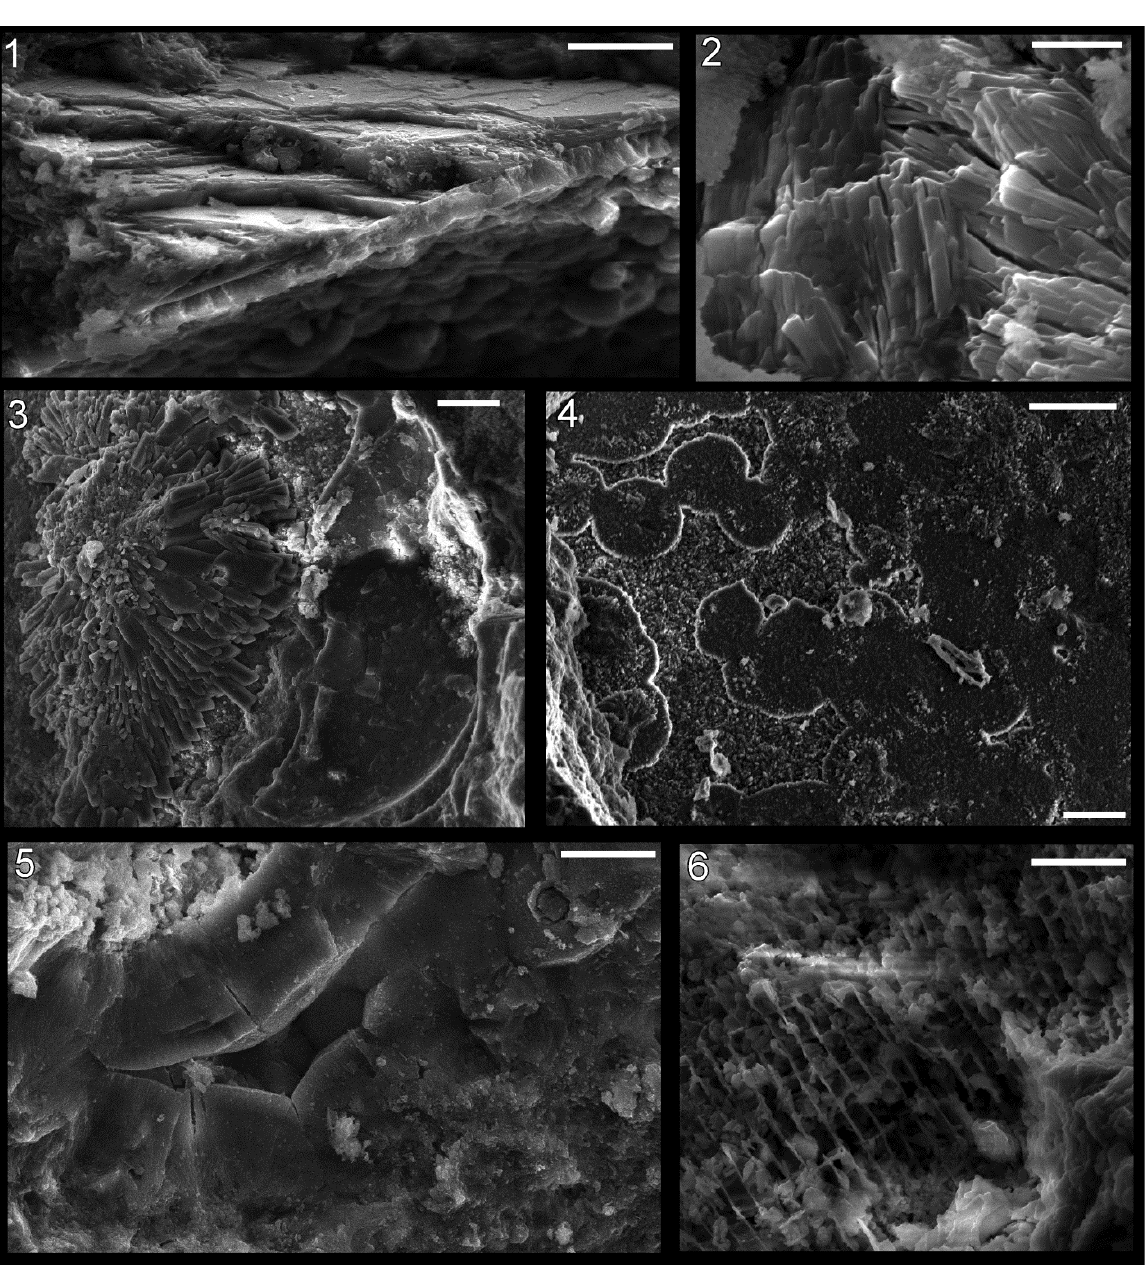
represents phosphatized nacre. Our model that this texture is largely diagenetic, while still revealing nacre, helps explain why three different classes of mollusc have a similar, unusual fossil shell texture. Figure 7. Shell microstructure in specimens of the bivalve Palaeoneilo sp. ( 1 )–( 4 ) and the gastropod Holopea sp. ( 5 ) and ( 6 ) from the Ordovician Maquoketa Formation. ( 1 ) and ( 2 ) LACMIP 14441: ( 1 ) semi-transverse section of a portion of replaced shell near midpoint of valve with umbo towards top of photo; ( 2 ) horizontal section of replaced shell near aperture; ( 3 ) LACMIP 14442, horizontal section of replaced shell in region between valve midpoint and aperture; ( 4 ) LACMIP 14436, horizontal section of inferred inner shell layer, near midpoint of valve; ( 5 ) USNM 553688, horizontal section of shell replacement; ( 6 ) LACMIP 14443, semi-horizontal view of external shell surface (outer shell layer) along lateral region of shell. Scale bars: 20 µm for ( 1 ), ( 3 )–( 5 ); 5 µm for ( 2 ); 10 µm for ( 6